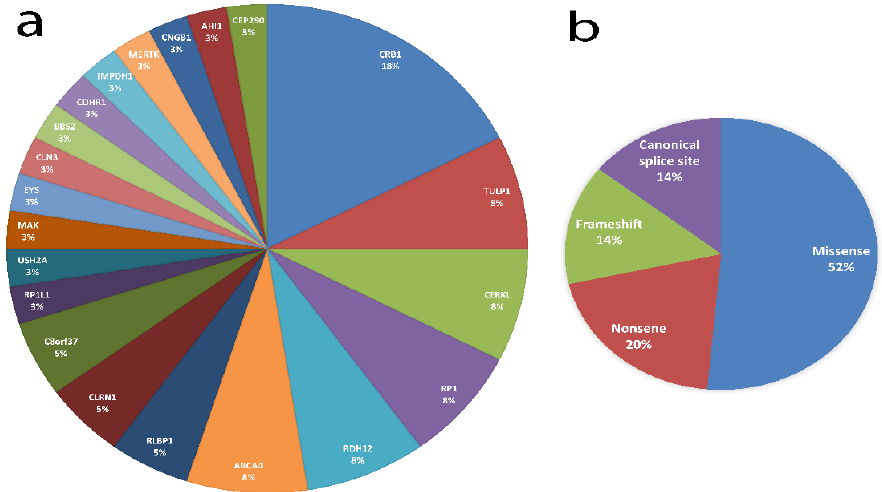
Figure 1. The characteristics of the identified disease-causing variants (DCVs) in our cohort. ( a ) Distribution of candidate DCVs per gene; ( b ) distribution of types within our cohort.